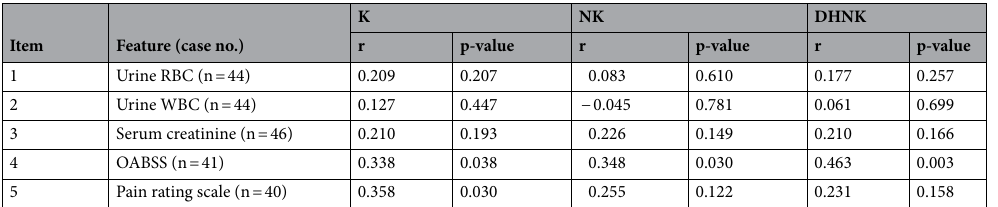
Table 3. Associations between urinary contents of ketamine and metabolites and clinicopathological features of KA. K ketamine, NK norketamine, DHNK dehydronorketamine, OABSS overactive bladder syndrome score.